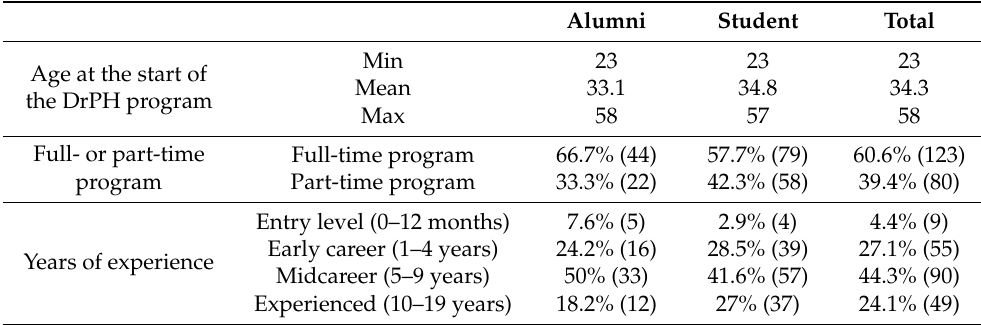
Table 1. Baseline